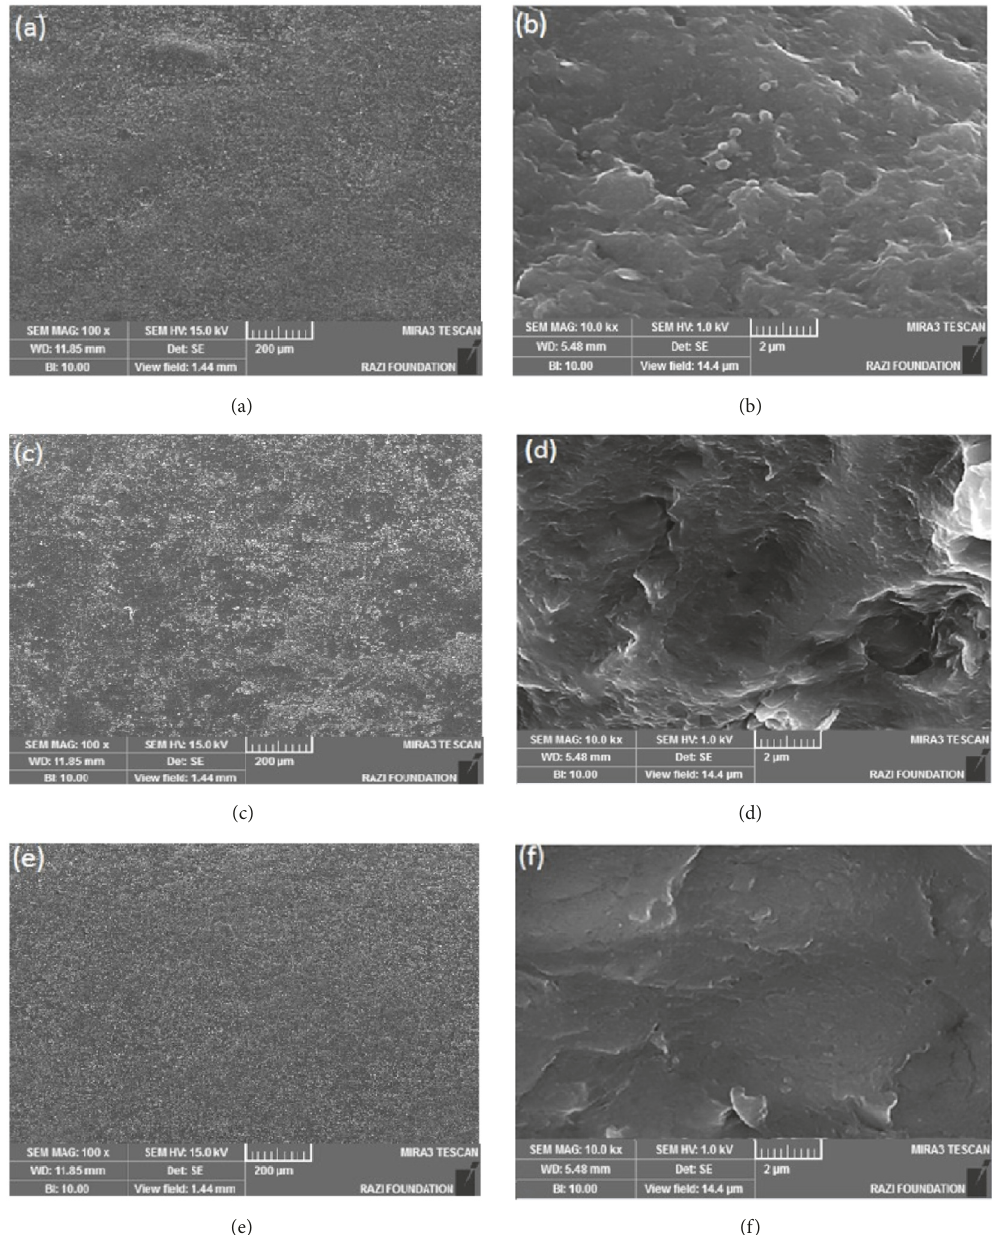
Figure 2: FESEM micrographs of WPI-gelatin based films: (a), (c) and (e) the surface; (b), (d) and (f) the cross section of WGN5, WGN5-21 and WGN5-21-TPP film samples. Table 2: Effect of orange peel extract on physical and mechanical properties of WPI-gelatin-MMT-OPE films. Films Moisture content (%) Water solubility (%) Transparency Tensile strength (MPa) Elongation at break (%) WG